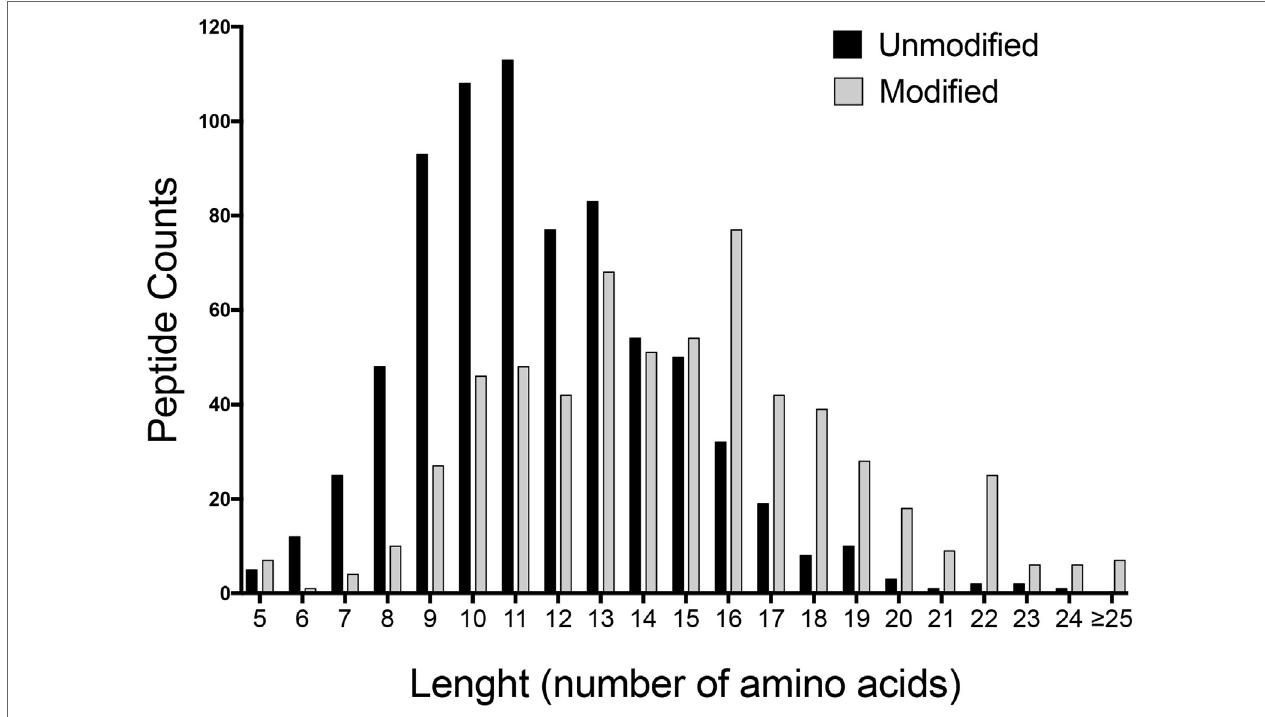
FigUre 1 | Length distribution of unmodified and modified identified peptides. Liquid chromatography–mass spectrometry of < 3 kDa mouse urine fraction detected over 1,300 distinct peptiforms. Graph depicts the summary of the amino acid length distribution of non-modified (746) and modified peptides (615) at a high confidence